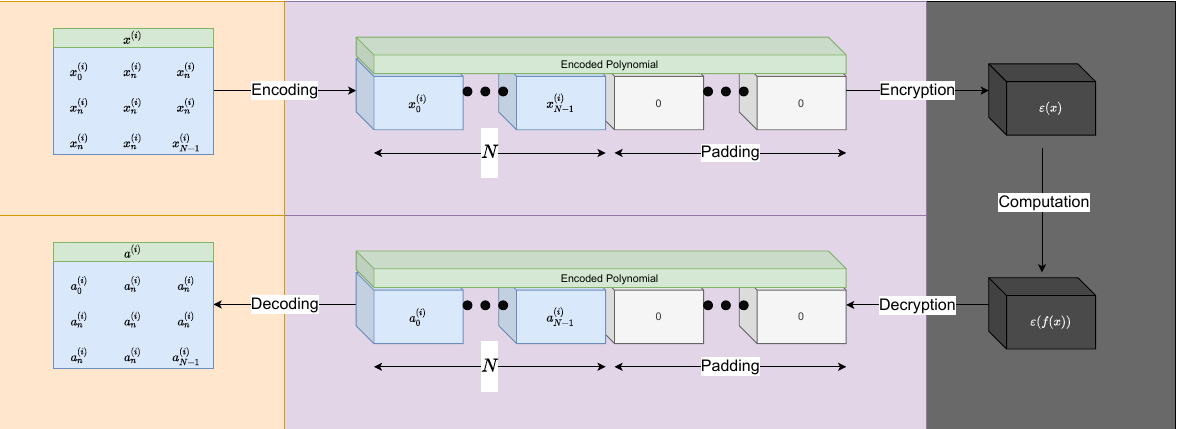
Figure 2. Fully homomorphic encryption (FHE) overview of distinct stages and properties